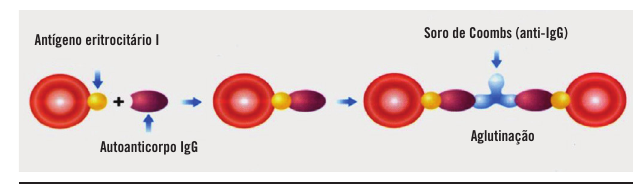
Figura 2 − Teste de Coombs direto